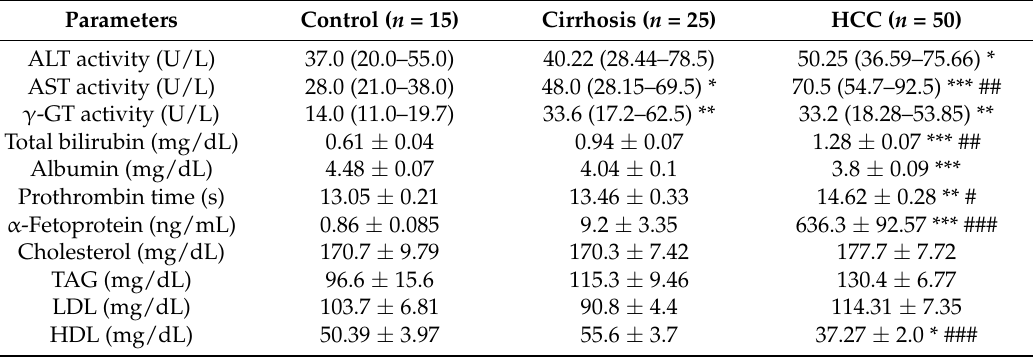
Table 2. Comparison of biochemical parameters in hepatocellular carcinoma (HCC), cirrhotic patients and control